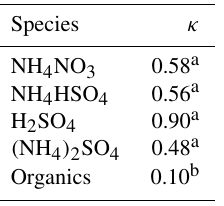
Table 1. The κ values of the related species in the study.